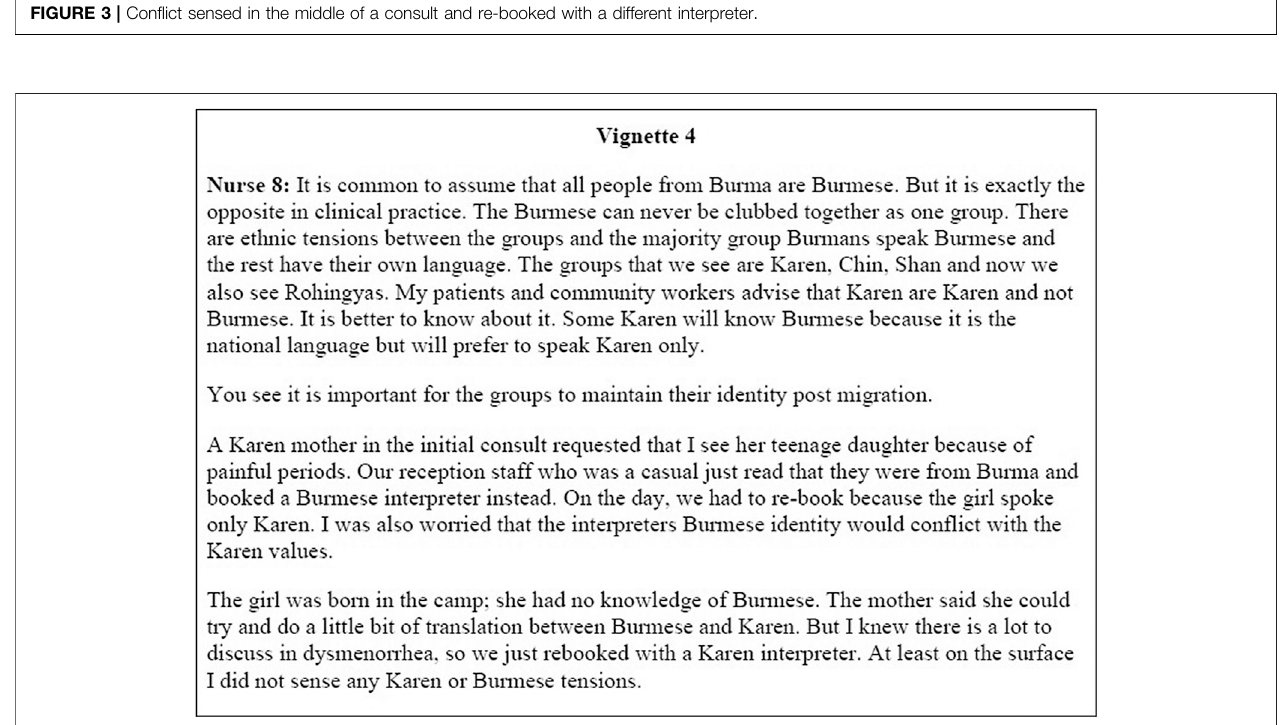
FIGURE 4 | A refugee health nurse describes that it is important to book the correct ethnicity and language matched interpreter prior to the clinical consultation.